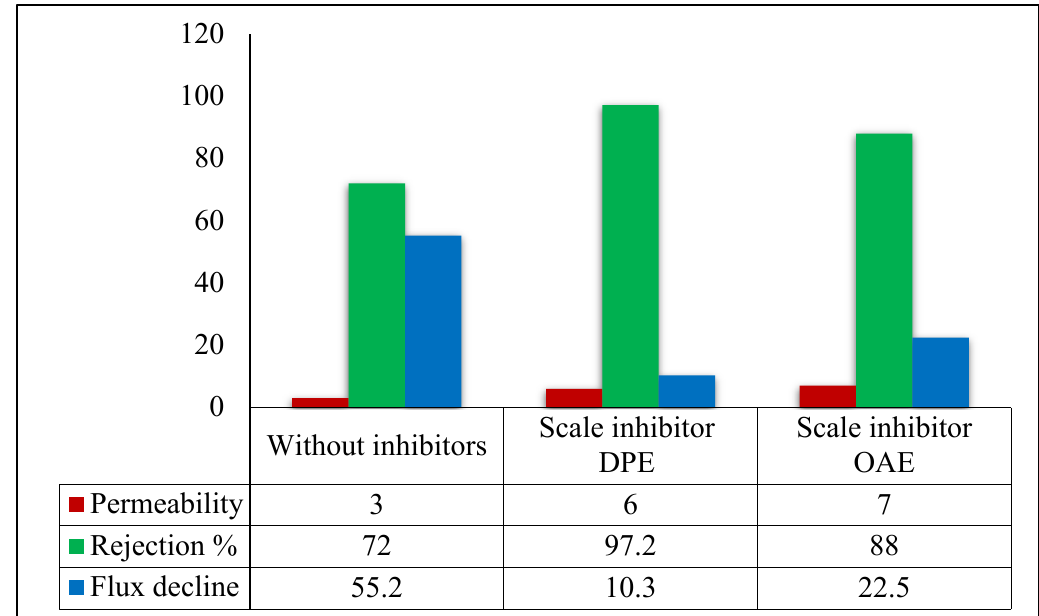
Figure 9. Membrane permeability, % scale rejection, and Flux decline (L/m 2 h) for membrane, without inhibitor; with scale inhibitor DPE; and with scale inhibitor OAE.